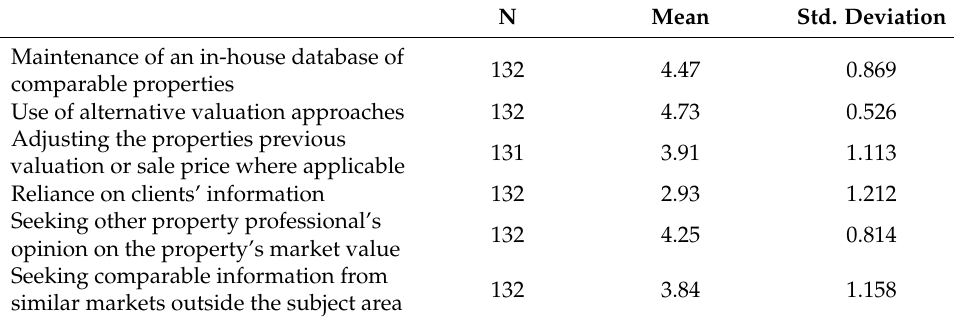
Table 7. Valuers’ response to limited and unreliable